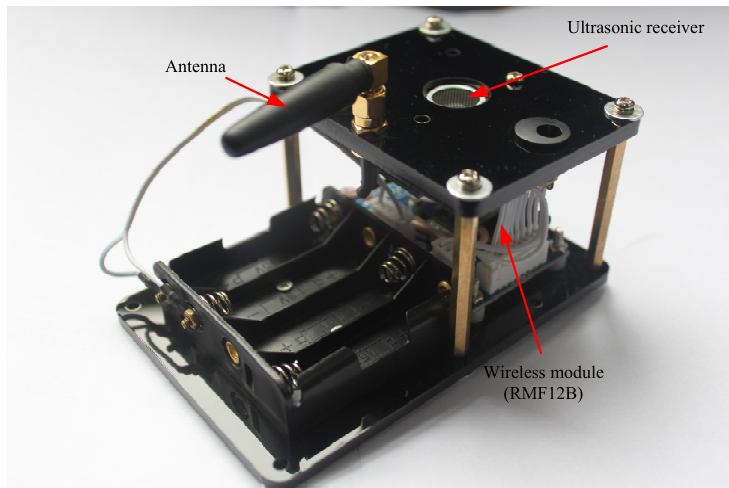
Figure 4. The prototype of the RN.